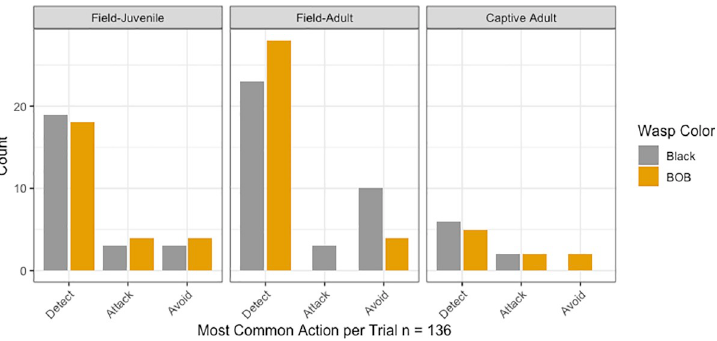
Fig 3. Most common behaviours of L . jemineus in trials with different combinations of wasp color (BOB vs black) and spider type. Each bar represents the proportion of spiders per type and wasp color (orange–BOB, gray–black), according to the most common action taken by the spider in each of the 136